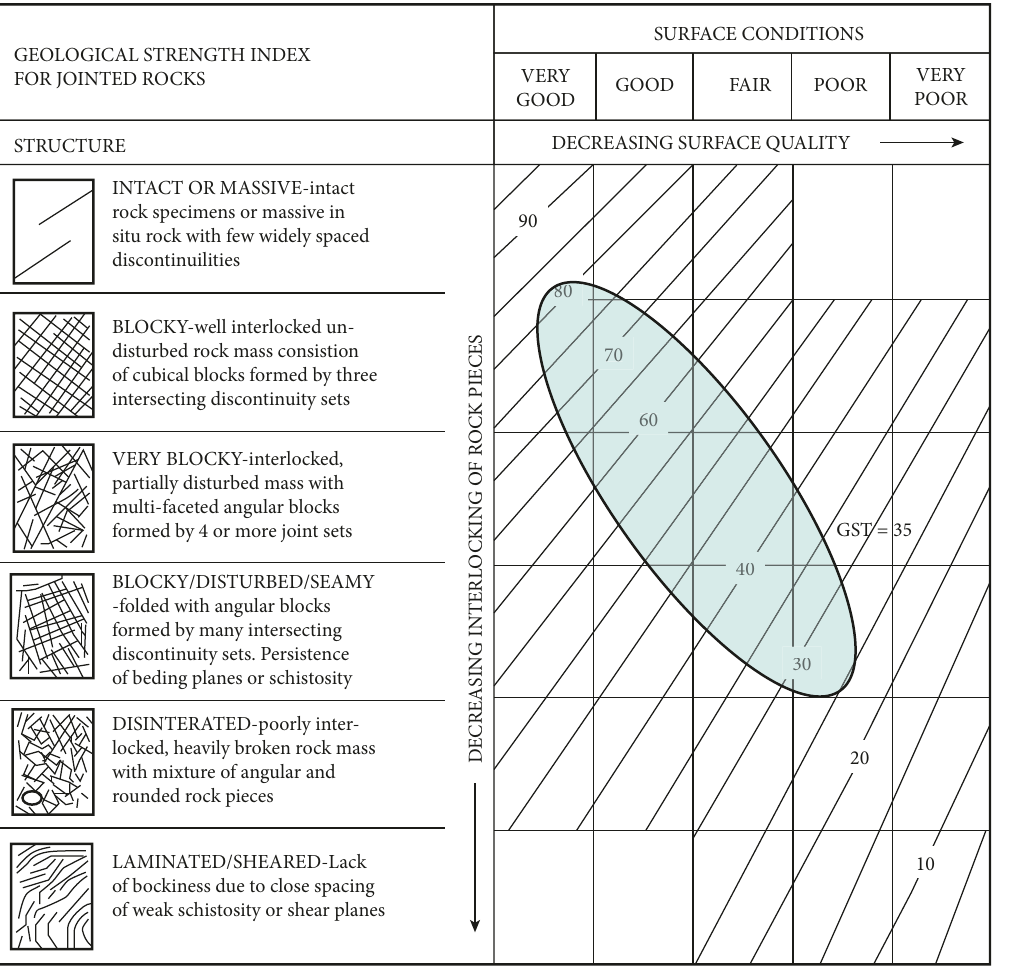
Figure 1: The chart shows the GSI values of Gorgan Quadrangle, Hoek et al.